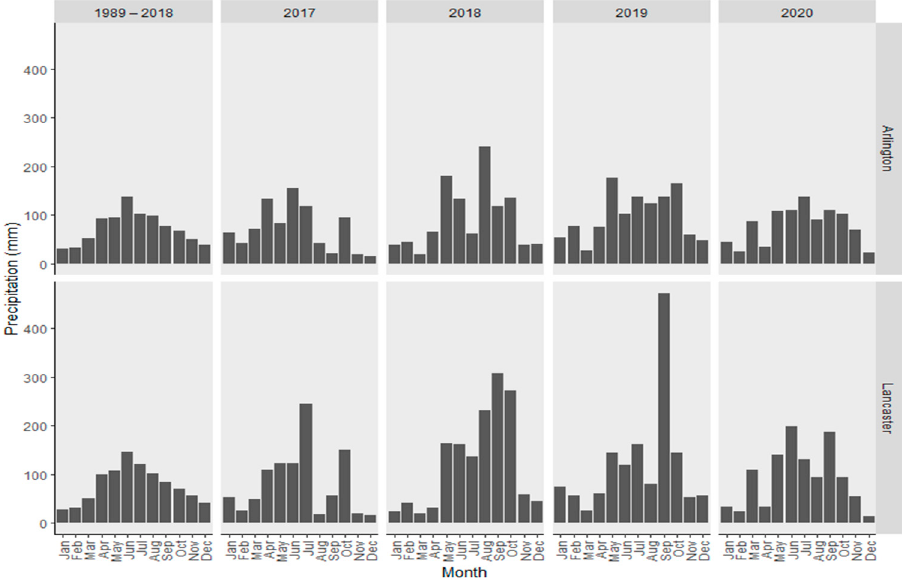
Figure 2. Monthly precipitation (mm) at Arlington and Lancaster for 30-year average (1989–2018) and experimental period (2017–2020) [24].